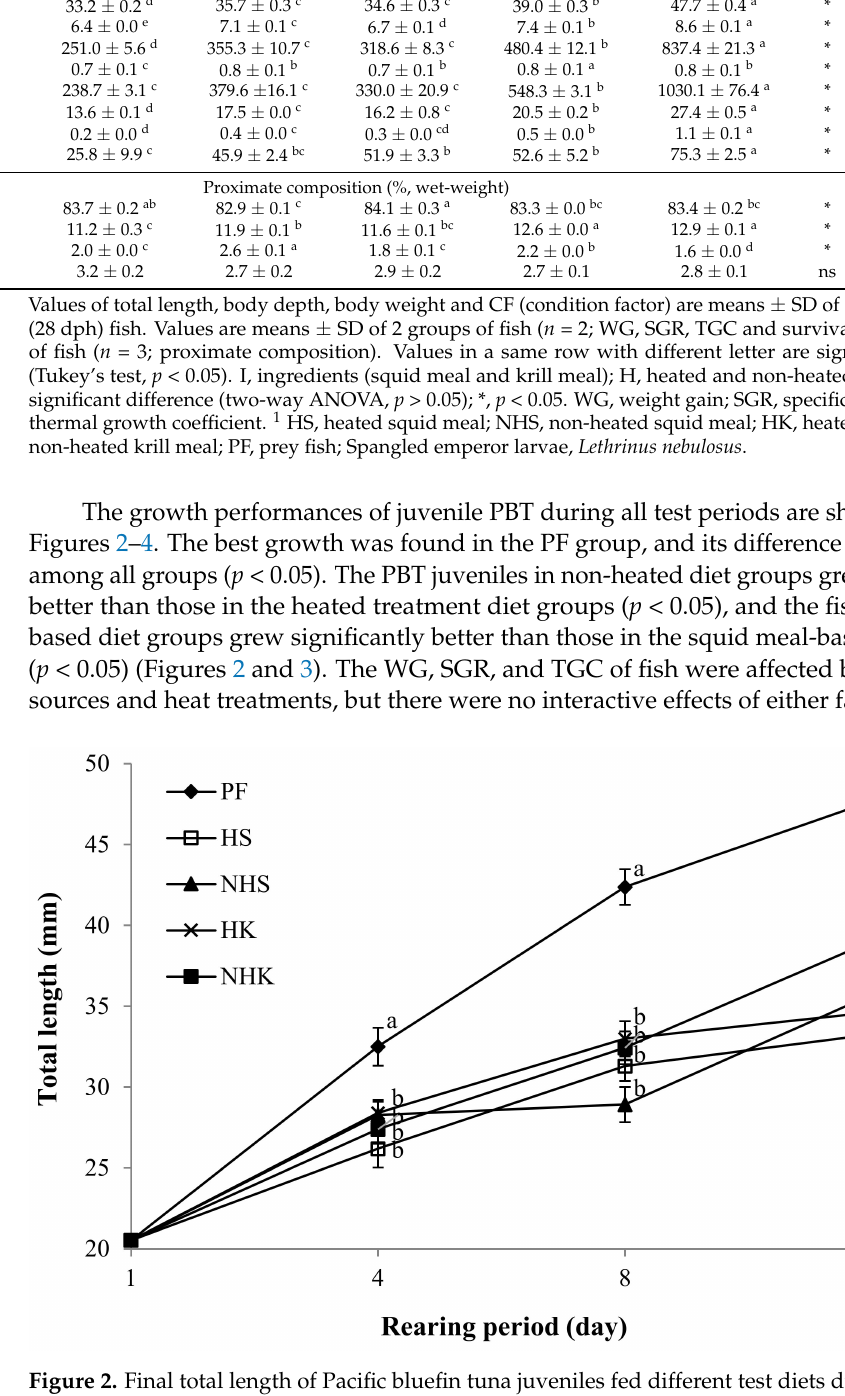
Figure 2. Final total length of Pacific bluefin tuna juveniles fed different test diets during the rearing period. Different superscript letters indicate significant difference among the dietary groups (Tukey’s test, p < 0.05; 1st day, n = 50; 4th and 8th day, n = 10; 10th day, n = 120). HS, heated squid meal; NHS, non-heated squid meal; HK, heated krill meal; NHK, non-heated krill meal; PF, prey fish; Spangled emperor larvae, Lethrinus nebulosus